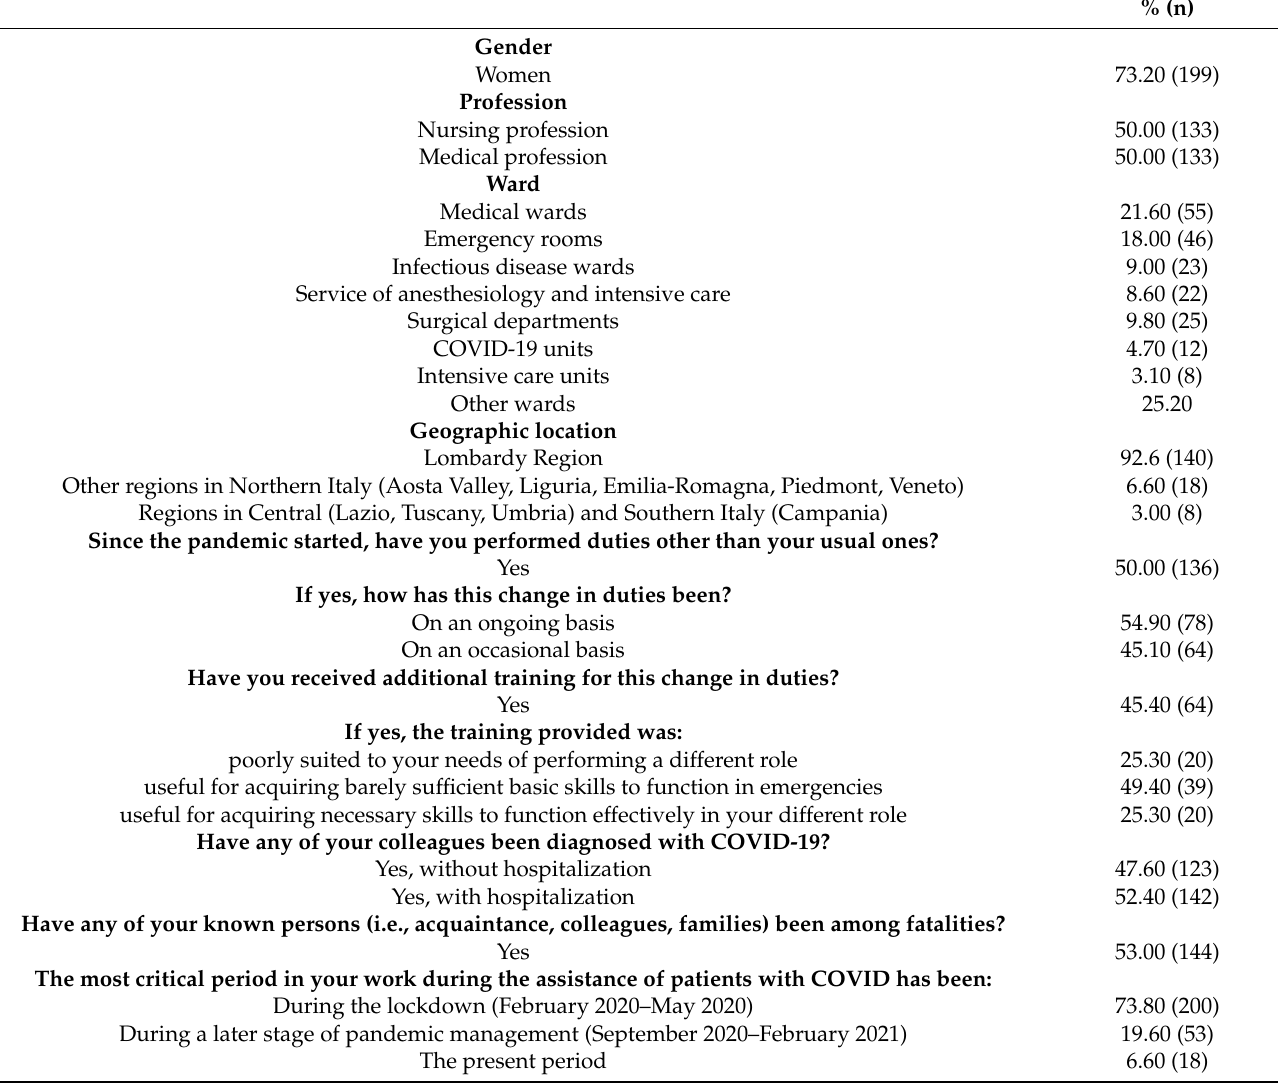
Table 1. Descriptive statistics of the sample (n =